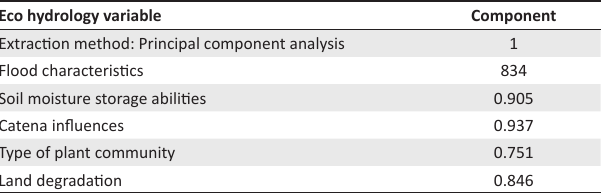
Table 4. TABLE 3: Principal component matrix. Eco hydrology